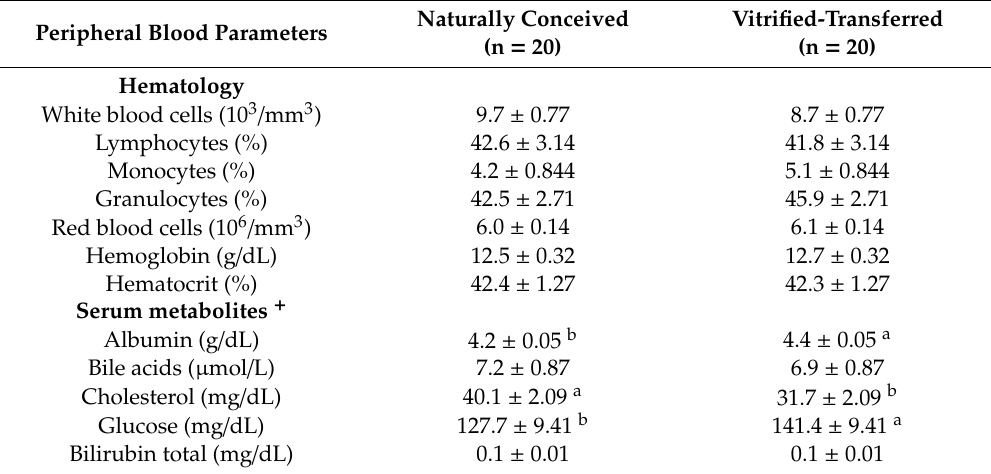
Table 2. Hematological and biochemical comparison between peripheral blood of adult, naturally conceived males and those derived from vitrified-transferred embryos. Peripheral Blood